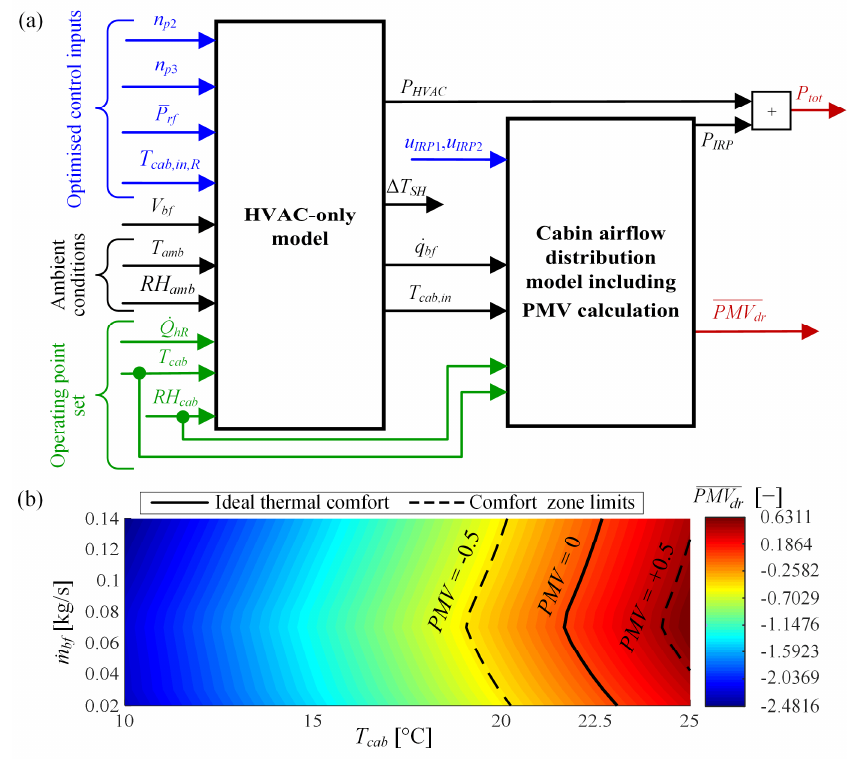
Figure 3. System model used within optimisation framework ( a ) and driver’s average thermal comfort index (PMV) map in dependence of cabin air temperature and inlet air mass flow rate ( b ).